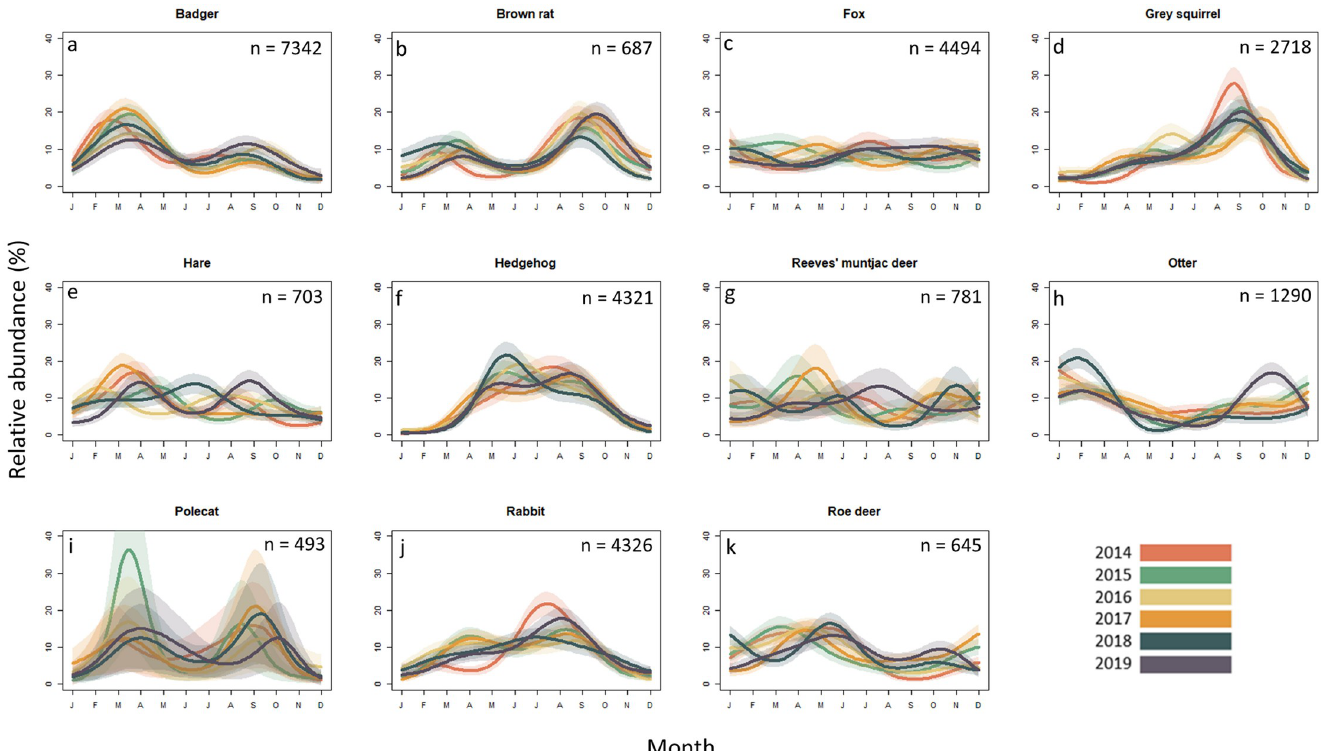
Fig 3. Seasonal variation in roadkill of mammals. Abundance (monthly percentage of annual total for each taxon) of the most common roadkill wild mammals in the UK. Records span 1 st January 2014 to 31 st December 2019. Shaded areas show 95% confidence intervals.